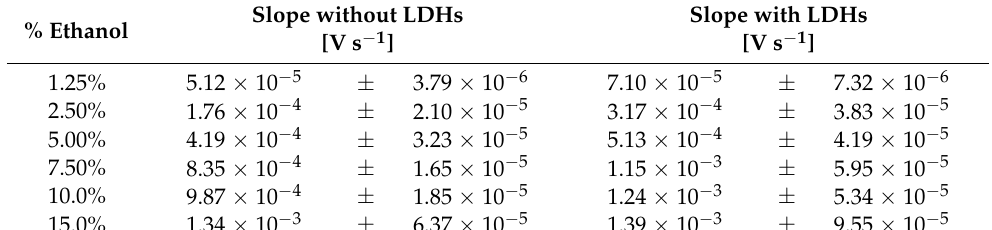
6 of 17 Figure 2. Open-circuit fuel cell voltage charge curves as voltage vs. time, performed by operating